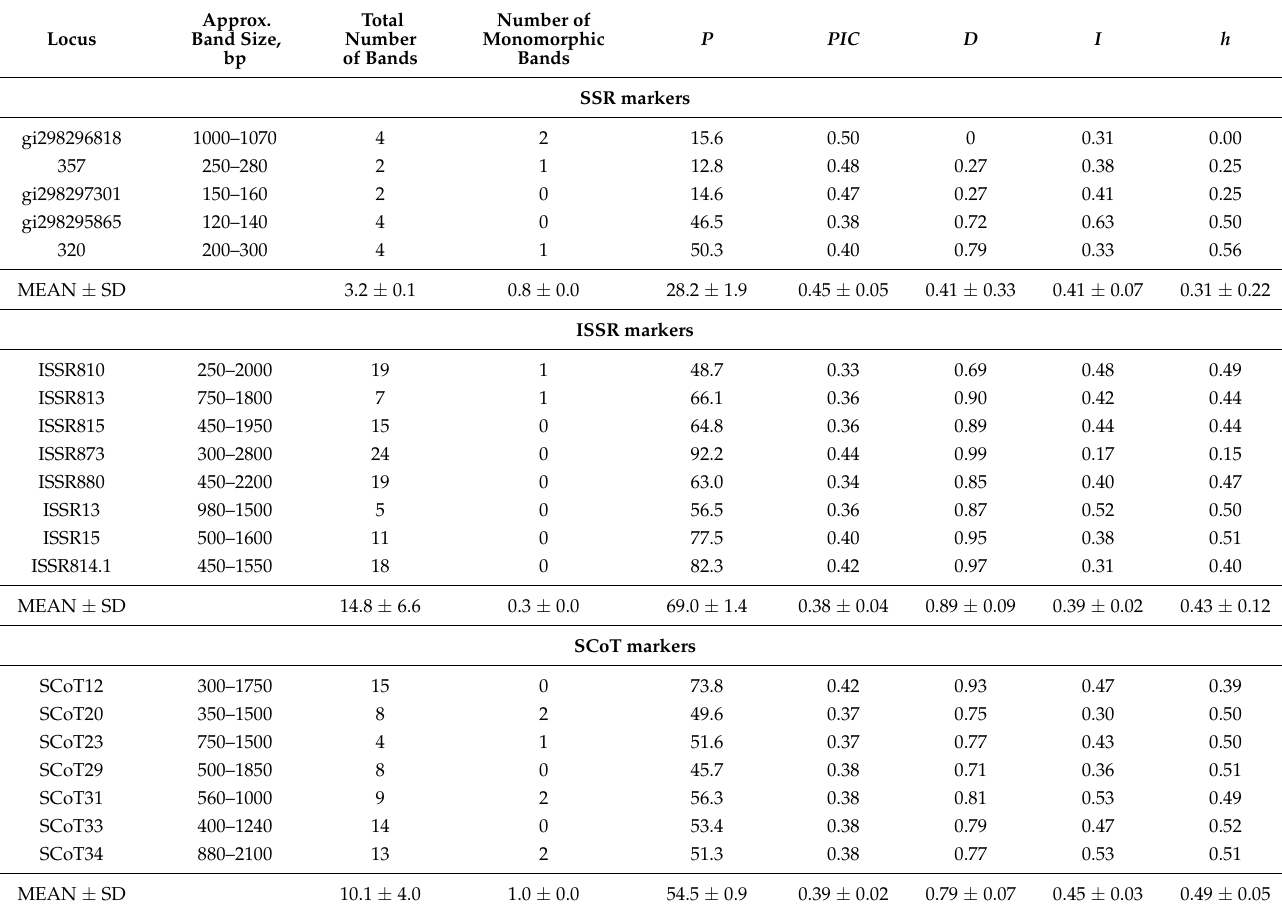
SCoT20, SCoT23, SCoT29, SCoT31, SCoT33, SCoT34) confirming their transferability to chrysanthemum (Supplementary file S1).